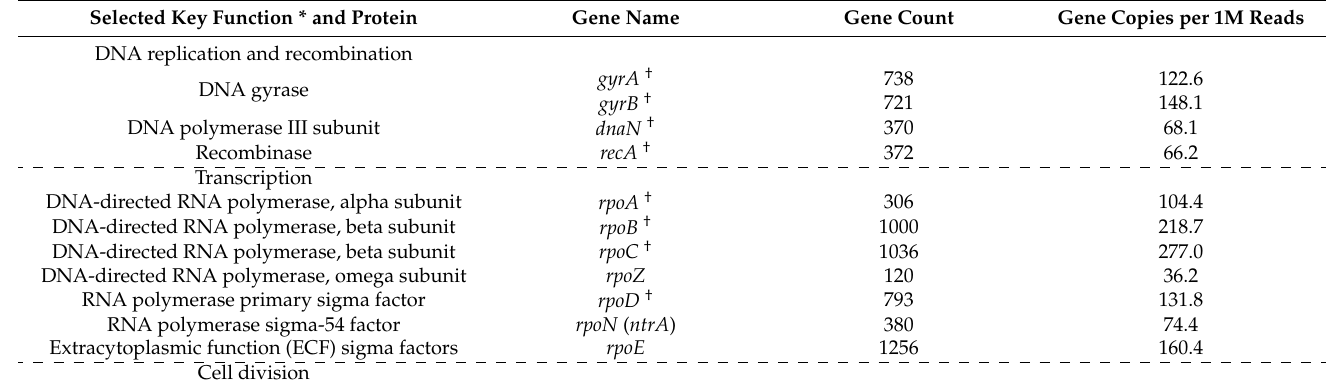
Table 2. Prediction-based number of selected key function and genes in Miscanthus rhizosphere soil of site